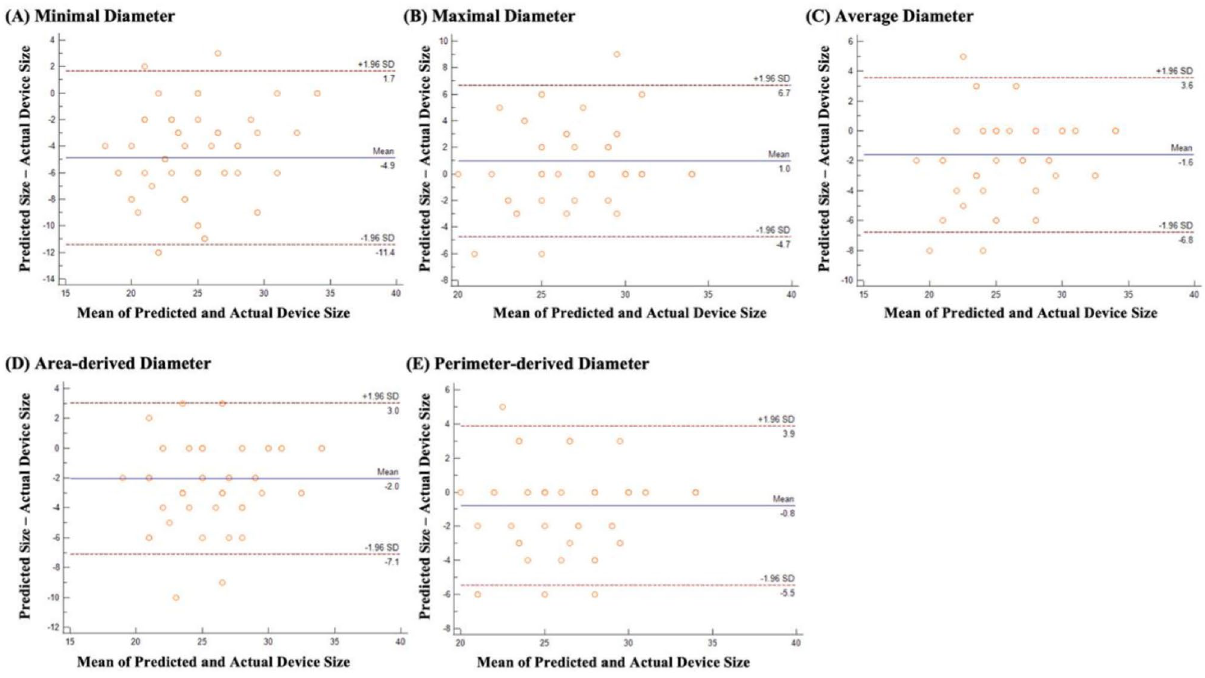
Figure 3. Bland–Altman plot comparing the predicted size using each parameter and actual device size of each parameter.